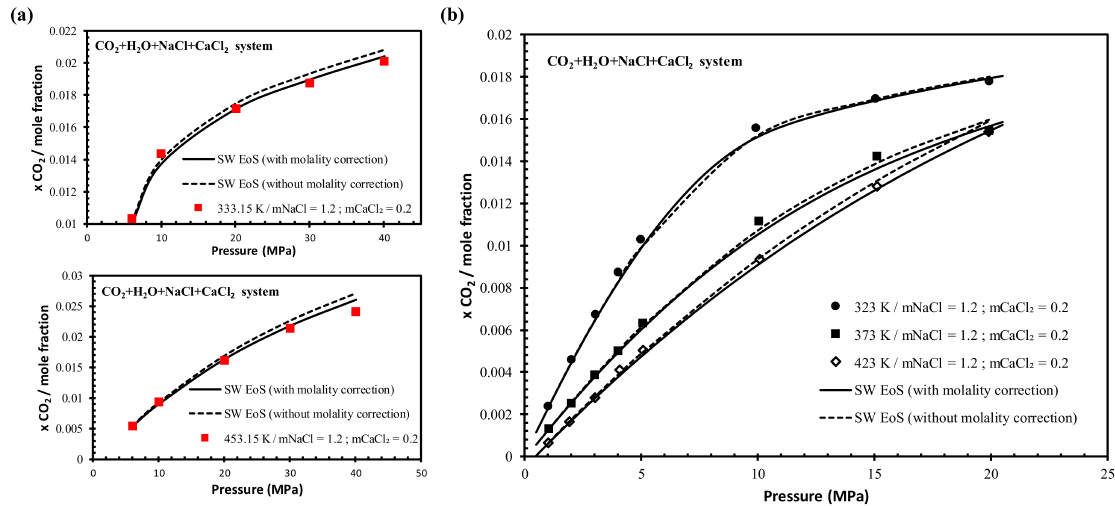
Figure 7. Prediction of CO 2 solubility in mixed-salt brine (NaCl + CaCl 2 + H 2 O) with (solid lines) and without (dashed lines) salt molality correction. Data (symbols) from: ( a ) [75]; ( b )